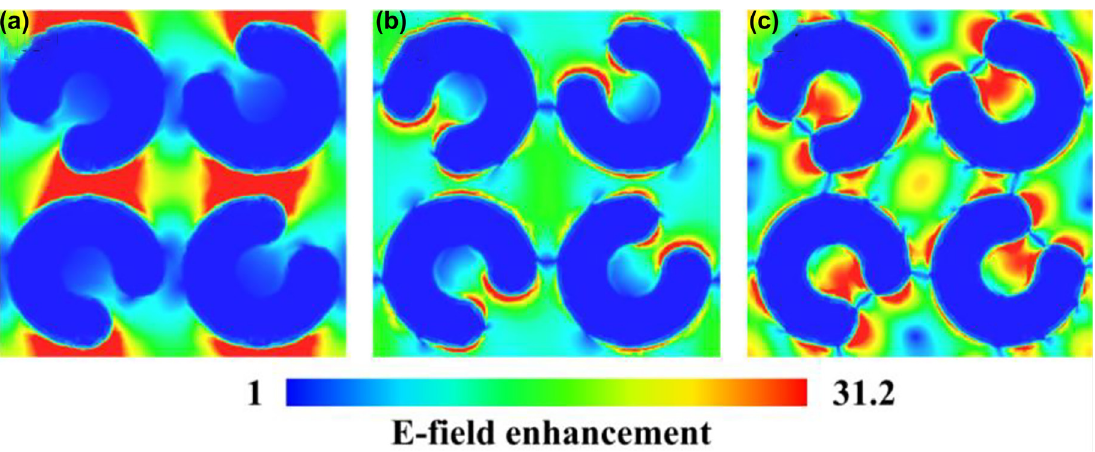
Figure 9: Numerically extracted E-field strengths at different frequencies.